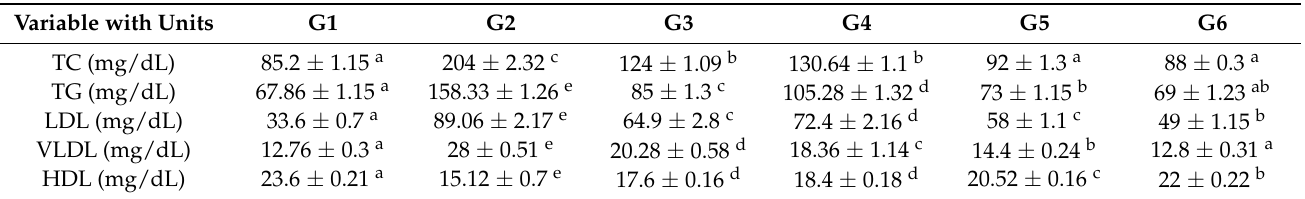
Table 1. Effect of Spirulina maxima extract, Lactobacillus casei ATCC 7469-fermented wheat bran extract and their combination on lipid profiles of Sprague–Dawley rats at 7